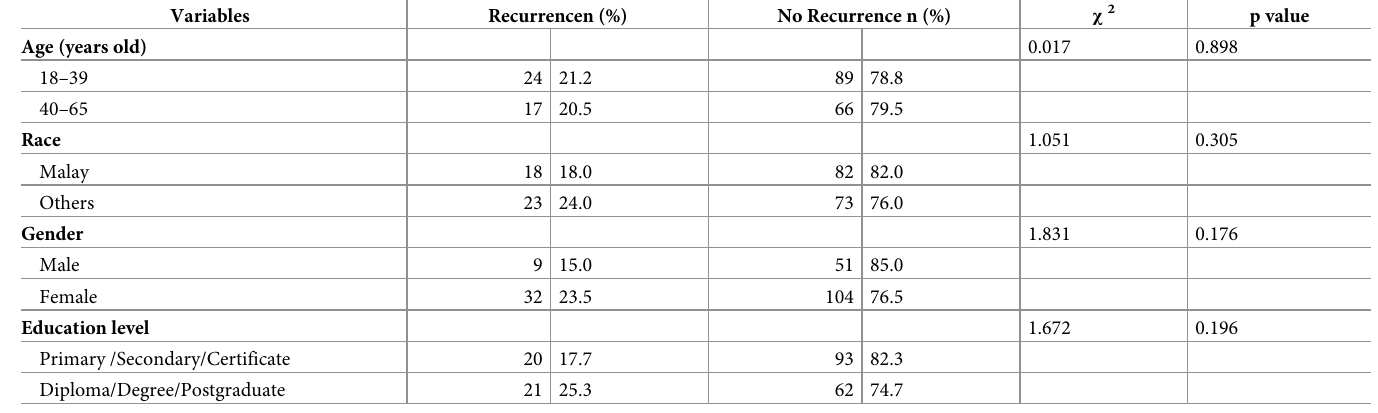
Table 2. Sociodemographic characteristics of study population by recurrence (n =